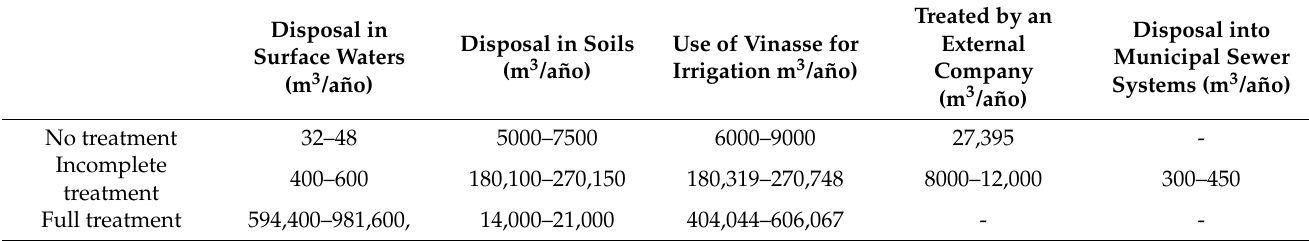
Table 7. Estimate of the vinasses disposed of annually in the state of